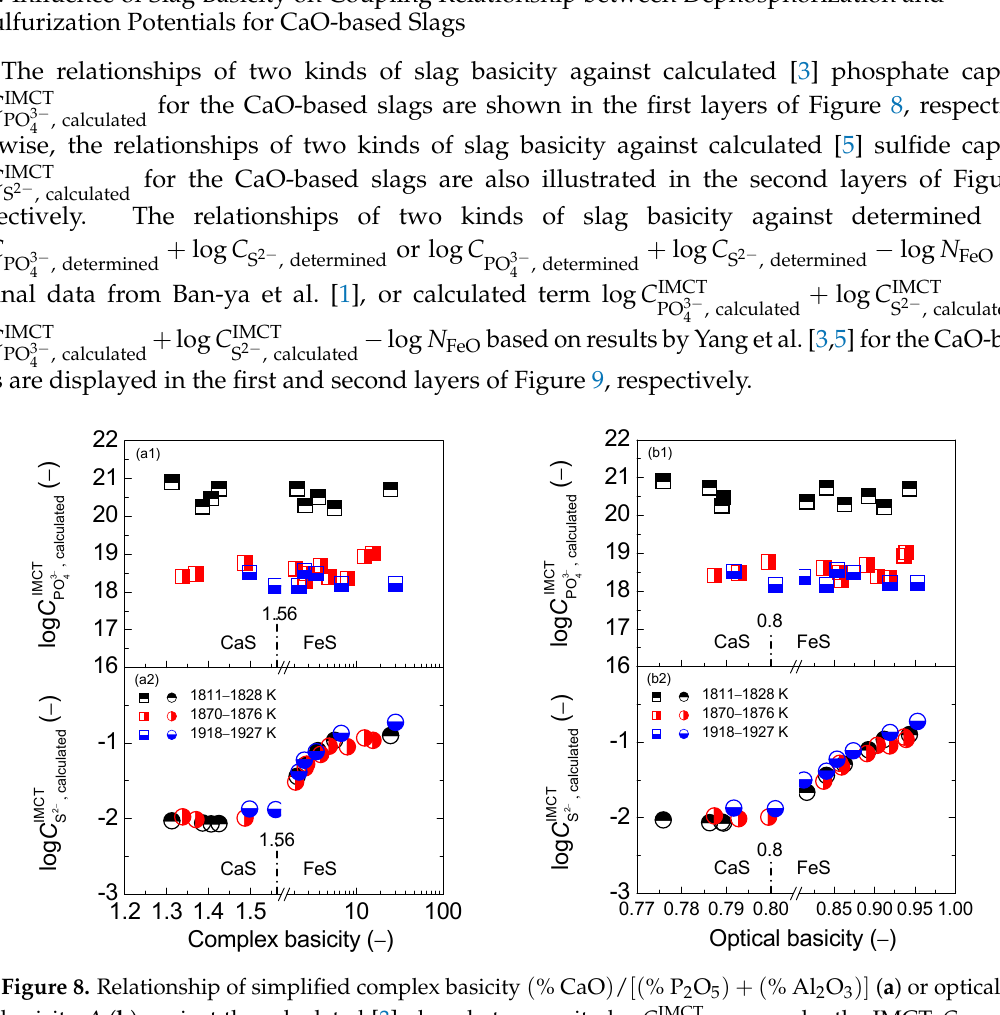
by the IMCT– C PO 3 − 4 PO 3 − 4 , calculated IMCT log C by the by the IMCT– C model in 3 4 PO , calculated S 2 − S 2 − , calculated IMCT log C by the IMCT– − C 2 2 S S , calculated